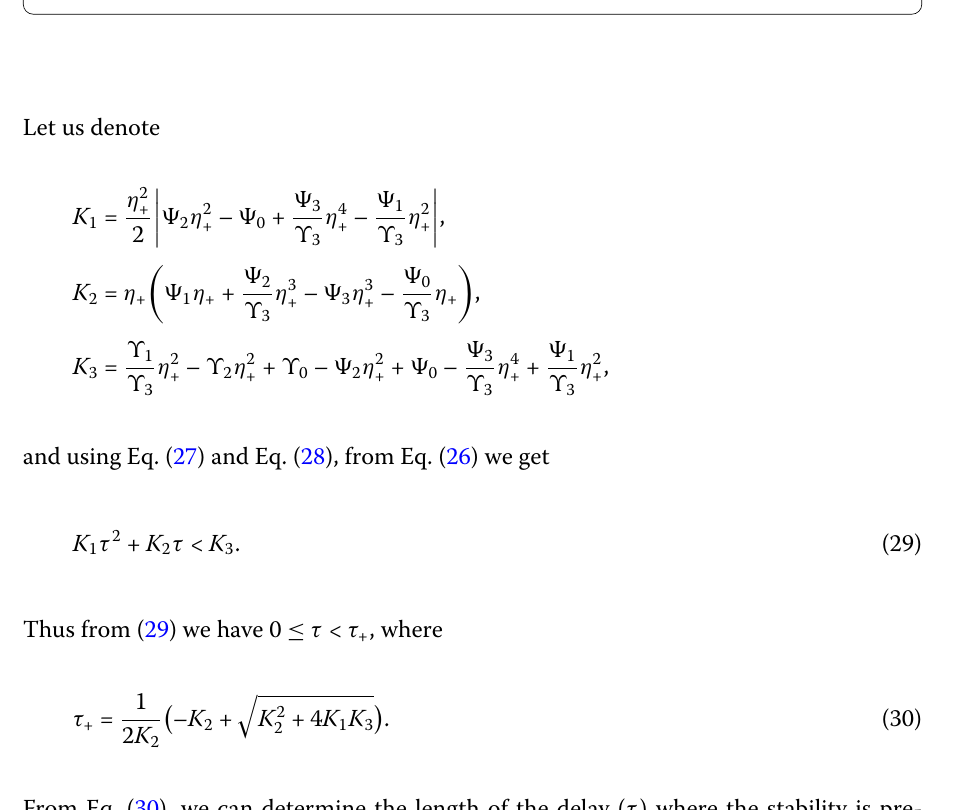
Figure 9 Phase plots for different ρ at τ = 2.8985. The rest of the parameters are taken as given in the